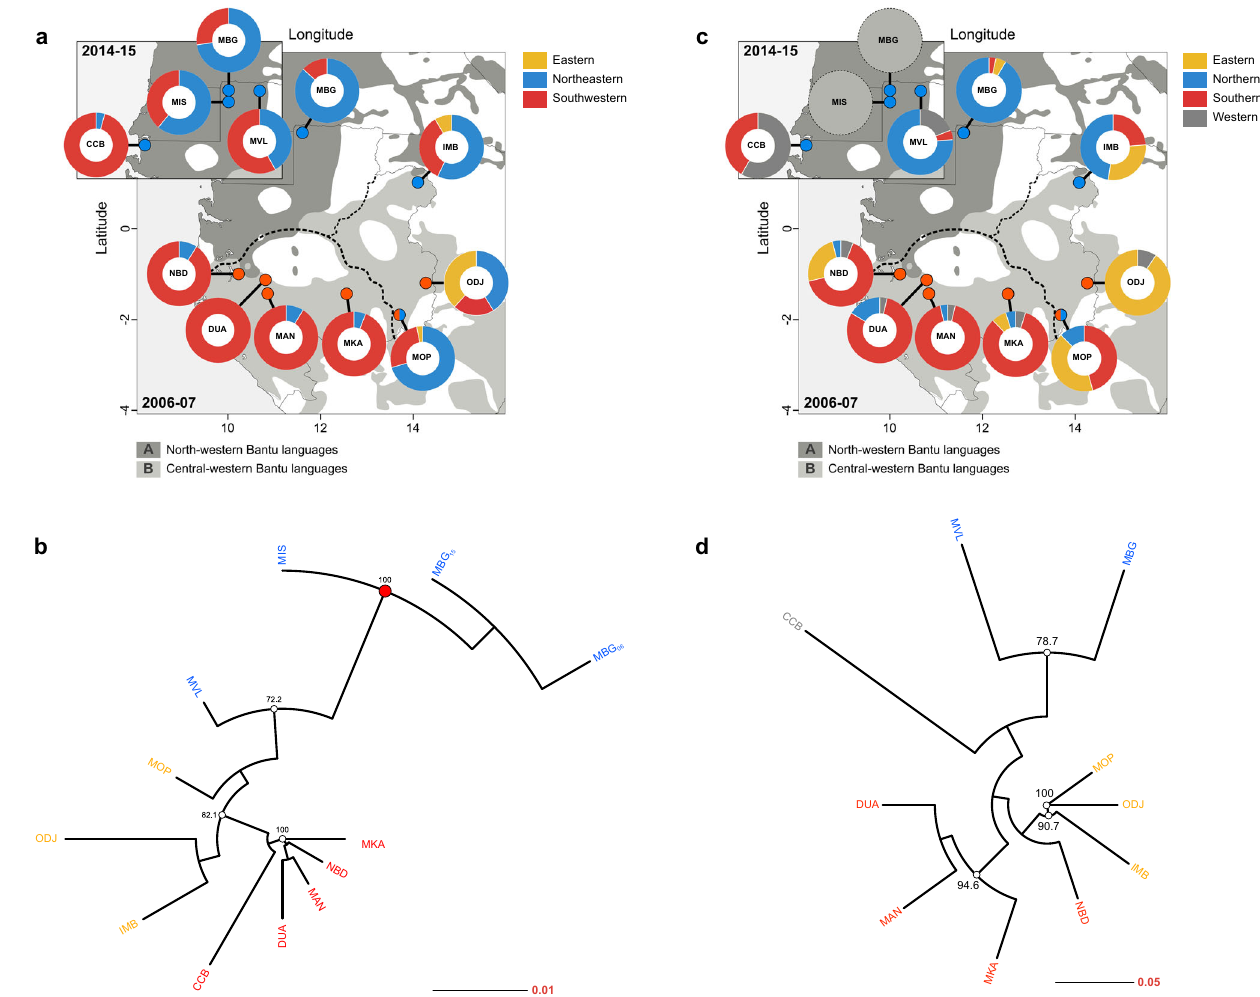
Fig. 2 Genetic structure in ACMV and cassava host populations in Gabon. a Bayesian clustering analysis of n = 346 ACMV viral sequences using BAPS. Matrilineal and patrilineal villages are indicated by red and blue dots, respectively. Pie charts show the distribution of viral haplotypes among the three regional clusters identi fi ed by BAPS. No evidence for admixture between groups was found. b Neighbor-joining tree based on Nei ’ s genetic distance 69 and 1000 bootstrap resampling. Bootstrap values >70% are shown as pie charts. c Bayesian clustering analysis of n = 423 cassava host plant multilocus genotypes based on nuclear microsatellites (Supplementary Methods). No genotypic data were available for MIS and MBG 2015 (empty pie charts). d Neighbor-joining tree based on Rogers ’ distance 70 and 1000 bootstrap